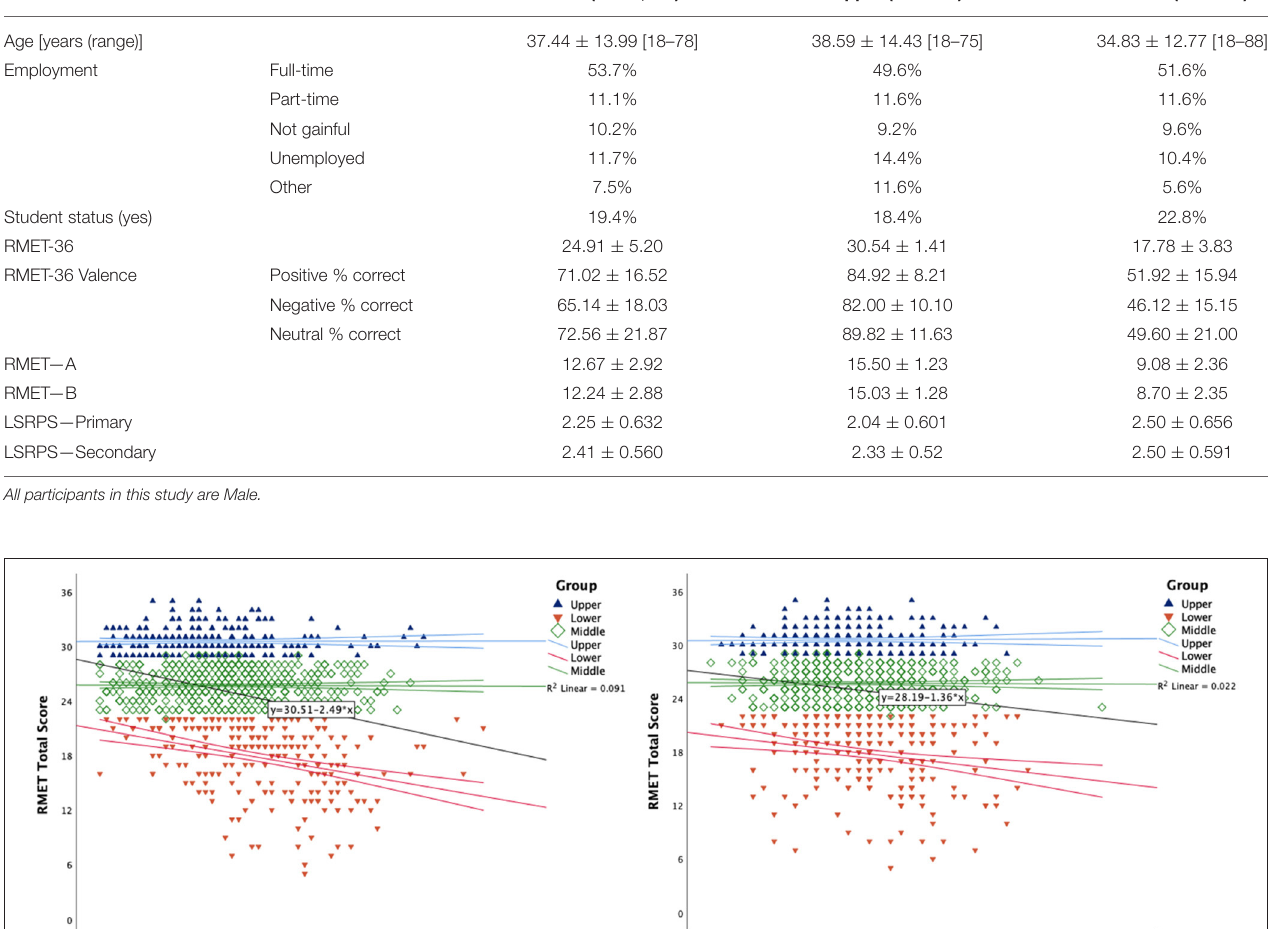
TABLE 1 | Participant demographics and outcome data, stratified by upper and lower quartile performance on the RMET. Variable